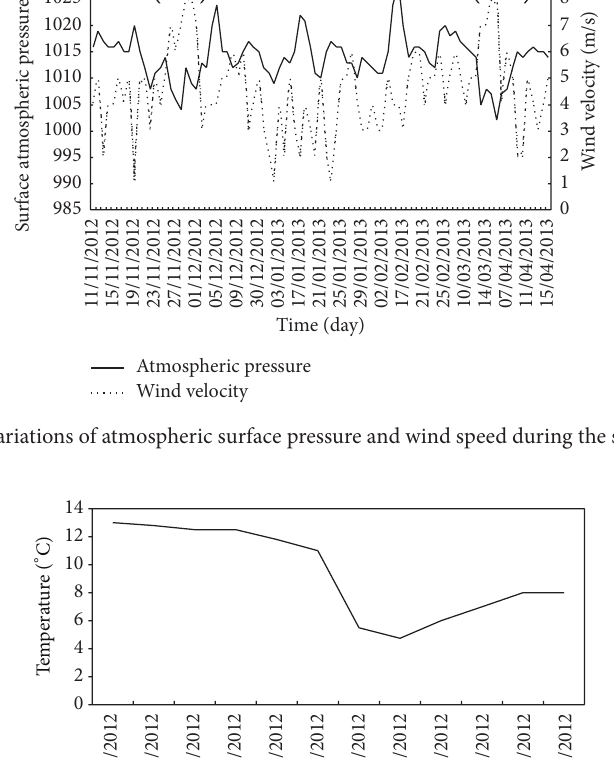
it represented 32% of sites (TS7, TS10, TS2, TS12,